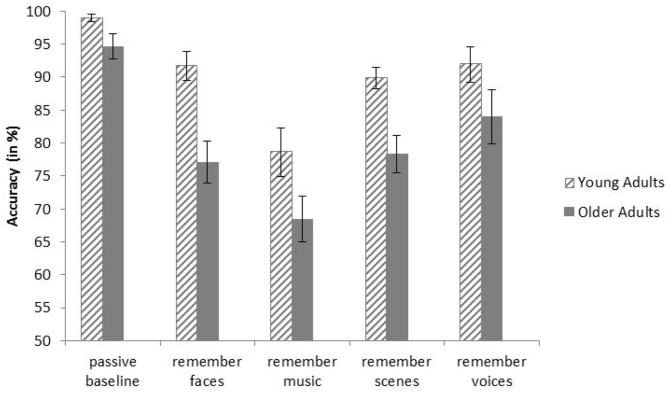
Mean accuracies of younger and older adults in all conditions of the behavioral task. Error bars indicate one standard error of the mean.